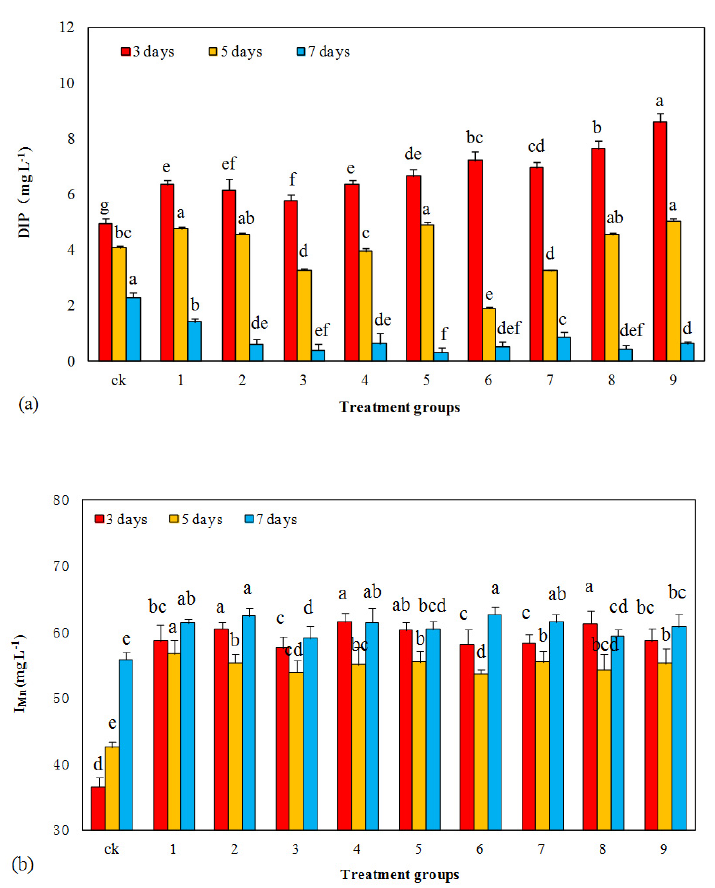
Figure 5. Influences of different allelochemical combinations on the water quality during orthogonal testing. ( a ) Dissolved inorganic phosphorus (DIP) concentration in the supernatant and ( b ) I Mn of the suspension. On the 3rd, 5th, and 7th days, significant difference of DIP and I Mn among treatment groups was marked with letter a–g, respectively (p < 0.05).